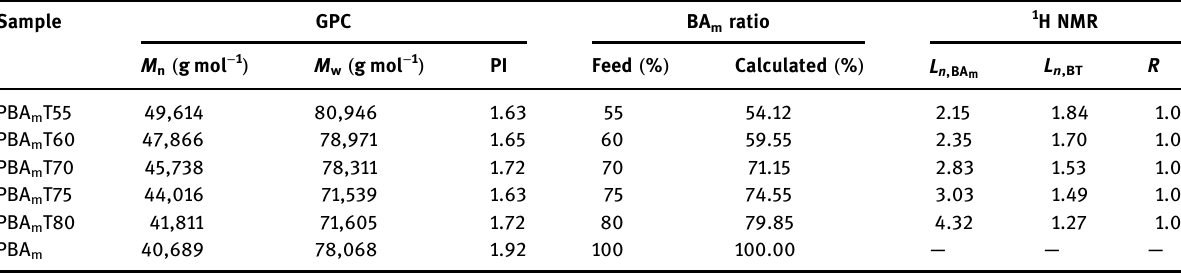
Table 1: Molecular weight and polydispersity characteristics of PBA m and PBA m T